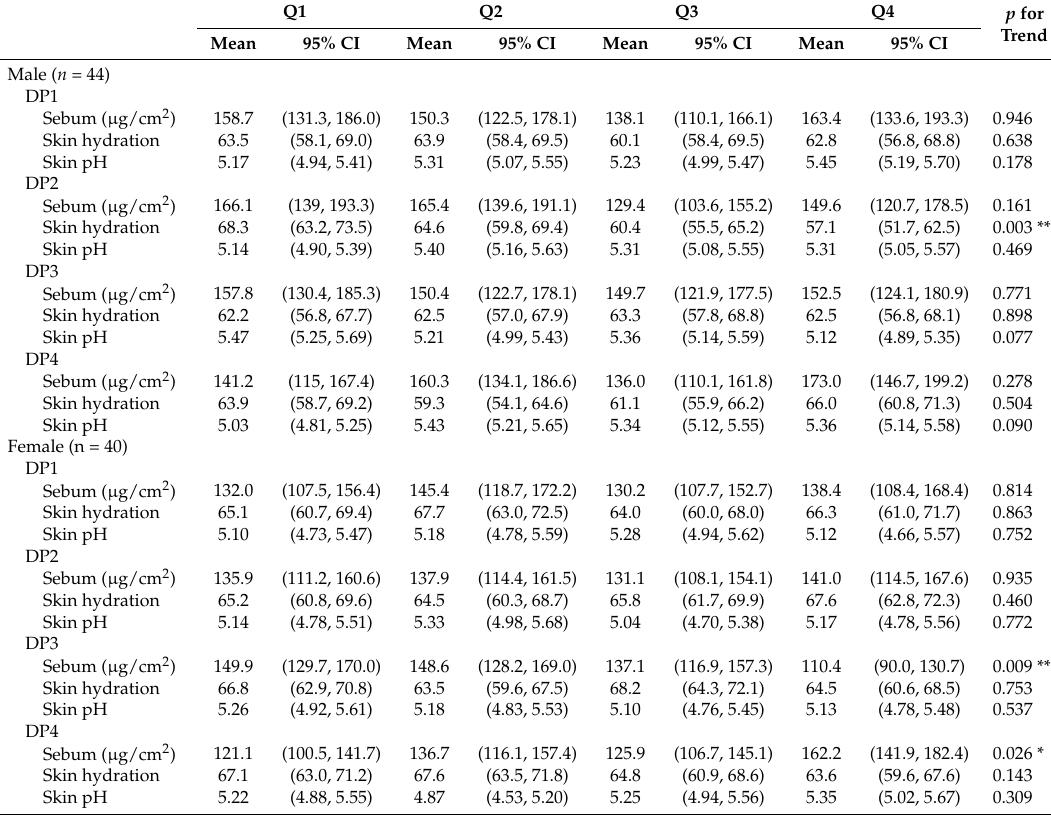
Table 4. Skin health parameters across the quartiles of dietary pattern scores by sex †. Q1 Q2 Q3 Q4 p for